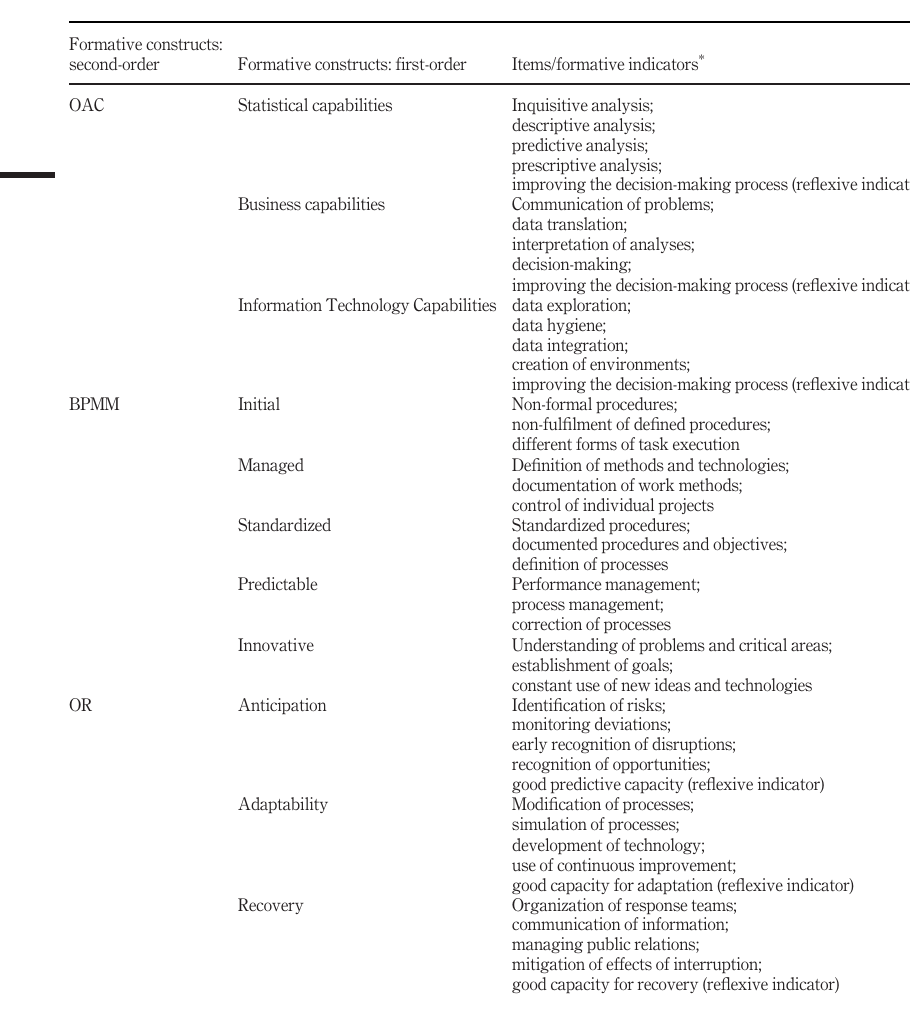
Table AI. Constructs and indicators of the study ’ s structural